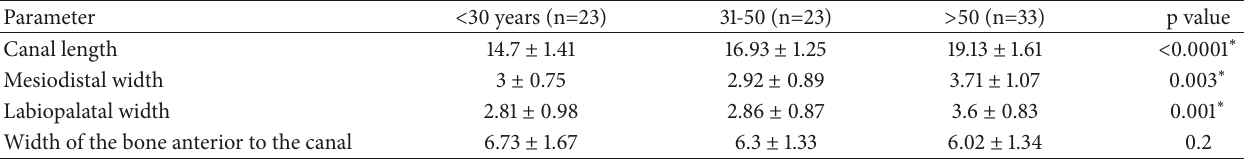
Table 2: Comparison of incisive canal characteristics according to age using ANOVA.